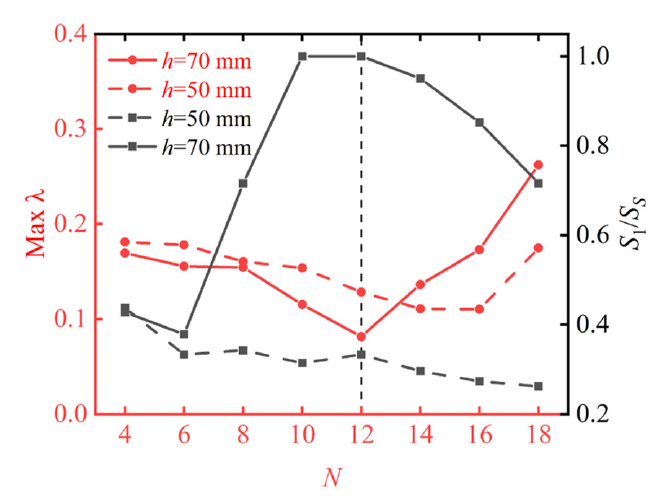
Figure 4. Influence of coil turn numbers N on B Z distribution.